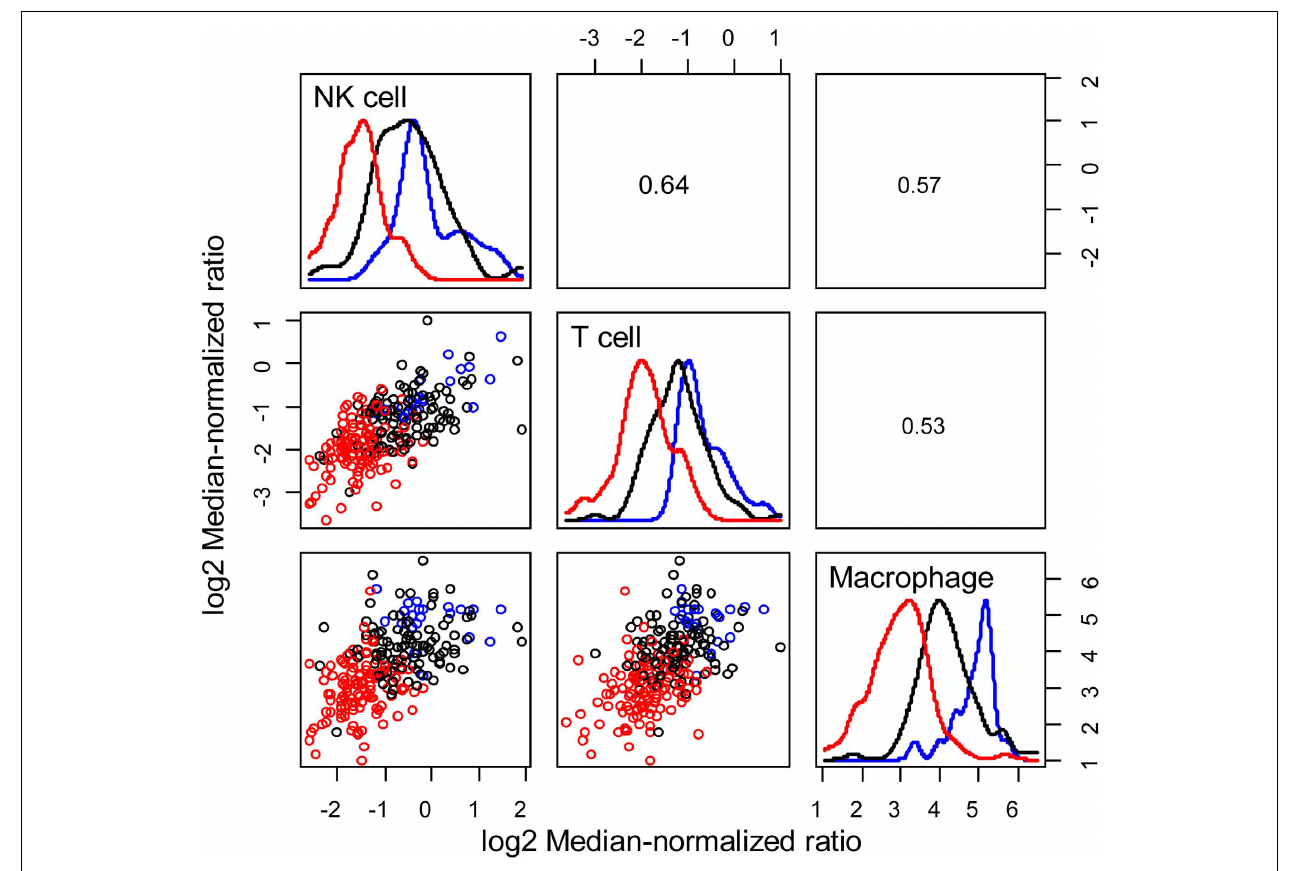
FIGURE 3 | Patient clusters exhibit different immune cell signatures. Relative immune cell infiltrate was estimated based upon the average expression of genes associated with NK cells ( KLRD1 , KLRC1 , KLRC2 , KLRC3 ),T cells ( CD247 , CD3G , CD3D , CD3E ), and macrophages ( CD14 ,